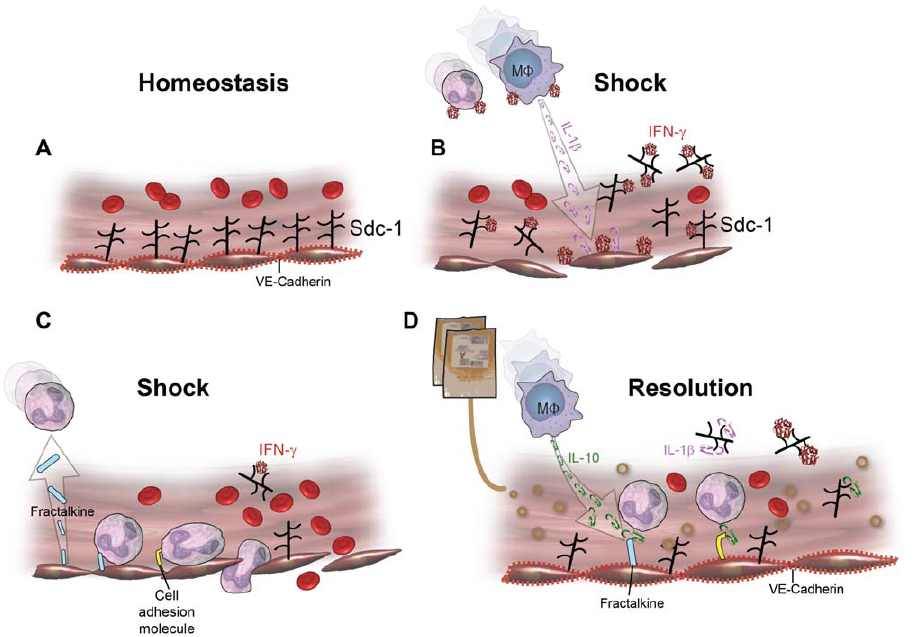
Figure 7. Proposed model of syndecan-1 interaction with inflammatory cytokines after shock and resuscitation with FFP. (A) Syndecan-1 (sdc-1) is a major constituent of the protective glycocalyx found on the surface of endothelial cells (ECs). (B) During hemorrhagic shock, syndecan-1 is shed from the EC surface, exposing the underlying endothelium to pro-inflammatory cytokines. IFN- c binds the heparan sulfate chains located on syndecan-1 and activates ECs which attracts neutrophils and macrophages to the site of injury. Macrophages further stimulate ECs by secreting IL-1 b . (C) Activated ECs secrete fractalkine, a neutrophil chemoattractant, and express cell adhesion molecules on the endothelial cell surface, facilitating pathologic leukocyte-endothelial cell interactions. (D) FFP acts to store vascular integrity. VE cadherins form an intact endothelium. IL-10 counteracts inflammation by decreasing expression of cell adhesion molecules. Shed syndecan-1 facilitates resolution of inflammation by removal of the pro-inflammatory cytokines, IL-1 b , IFN- c , and fractalkine.